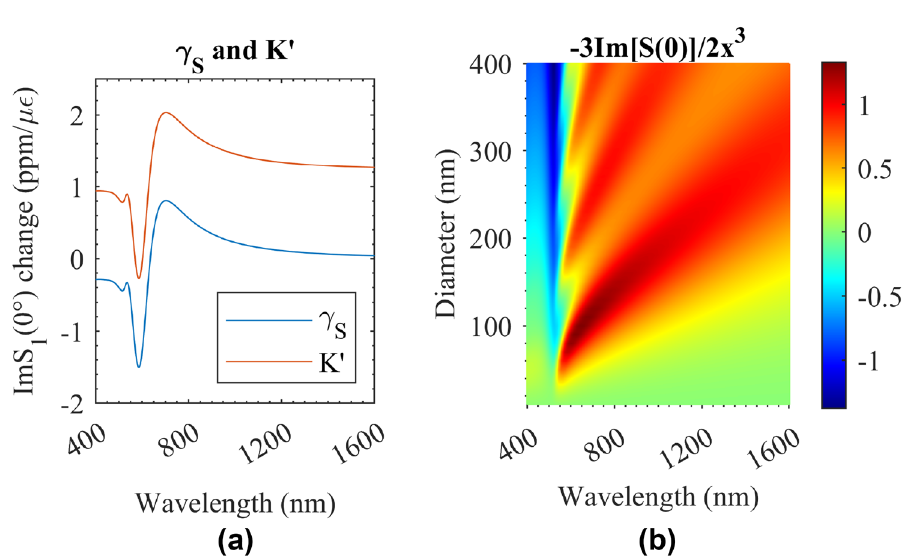
Figure 4. The nonlinear factors. ( a ) γ S and K ′ ; ( b ) The coefficient before K ′